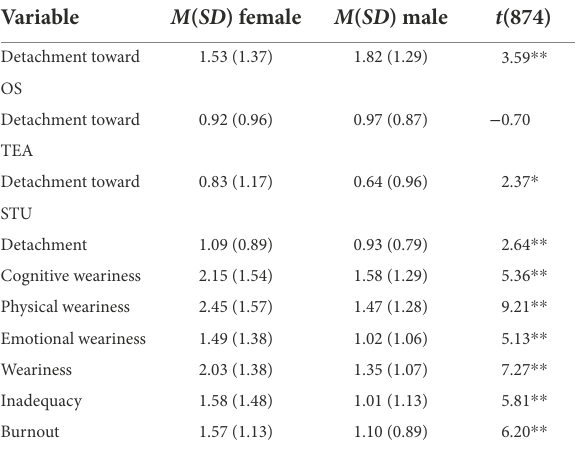
TABLE 4 Comparison of burnout (sub-)dimensions means between genders.